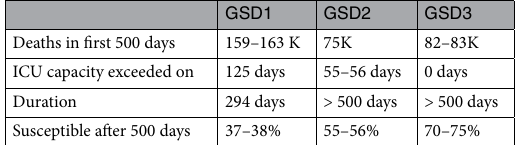
Table 7. Results for the group-specific social distancing